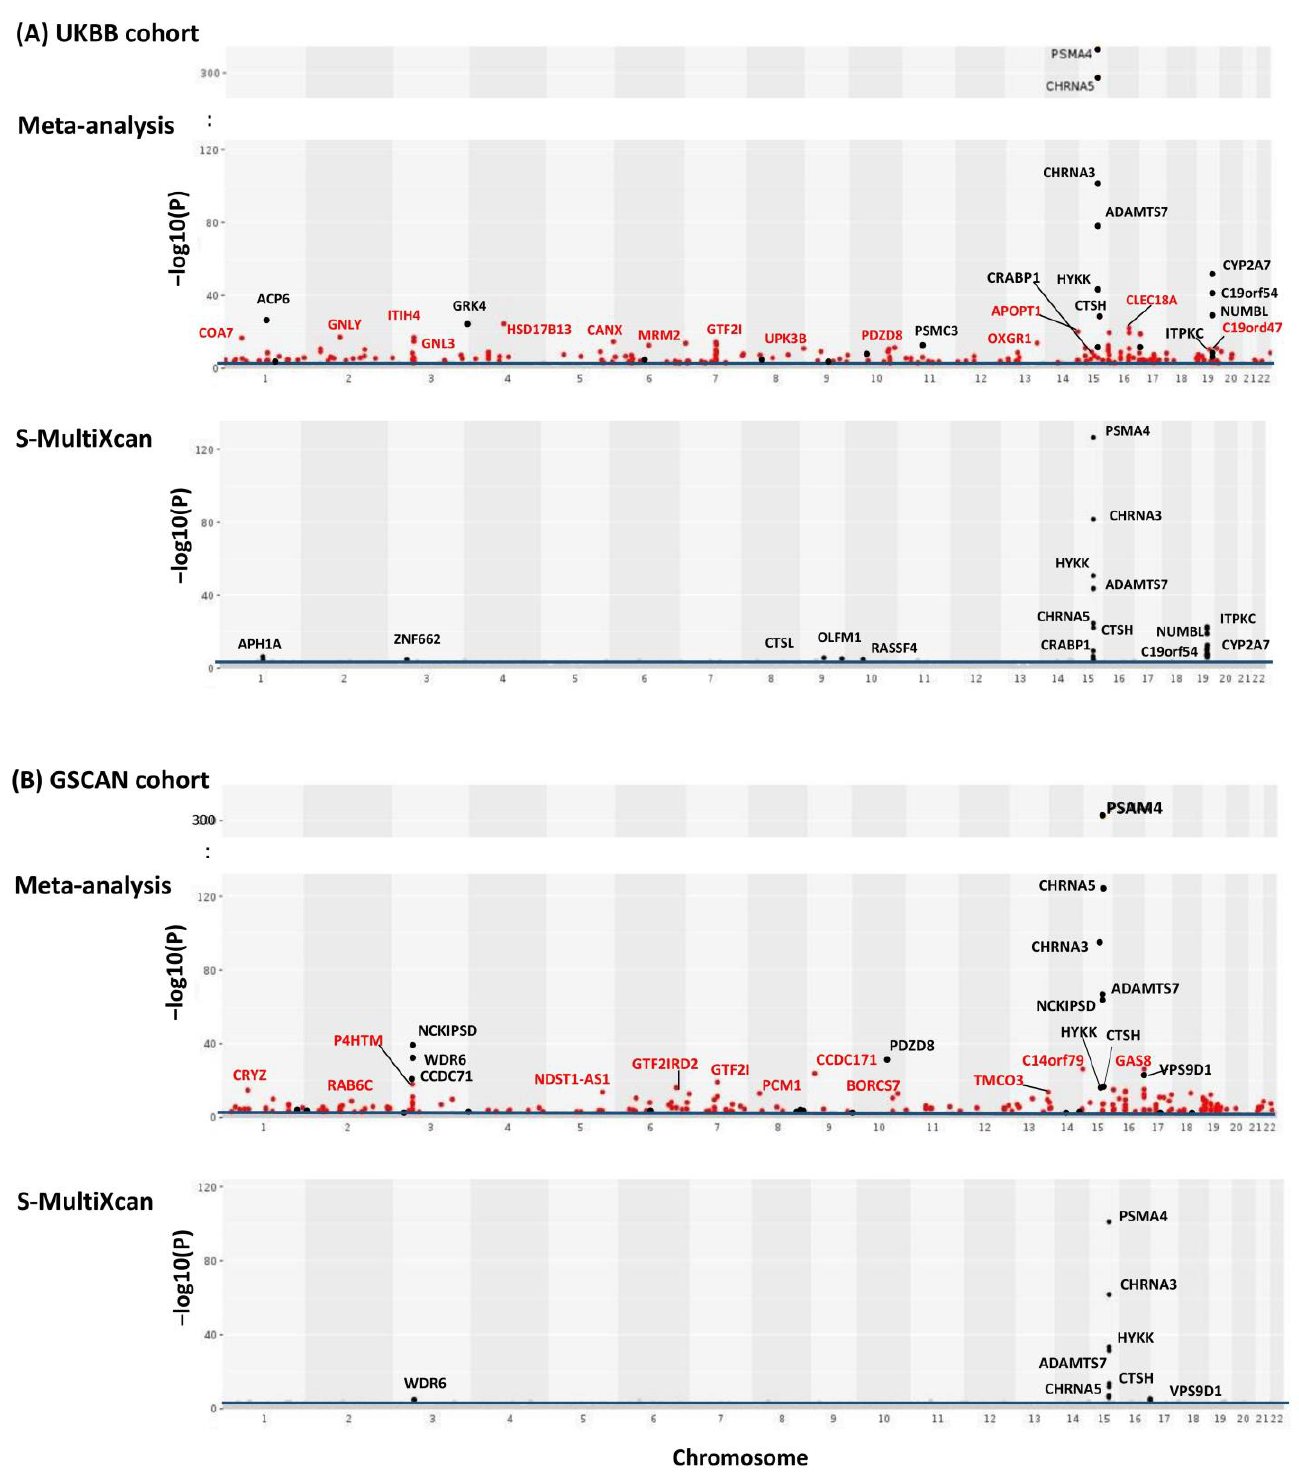
Figure 2. Manhattan plots of meta-analysis of TS-TWAS results across all 13 brain tissues for both UKBB ( A ) and GSCAN ( B ). Y -axis is the − log10( 𝑝 𝑔𝐴𝑊 ) from AW-Fisher. Results from S-MultiXcan are used for comparison. The blue line indicates an FDR cutoff of 0.05. Genes detected by meta-analysis but not by S-MultiXcan were highlighted in red and genes passing the Bonferroni cutoff (i.e., p < 0.05/#genes) were labeled.